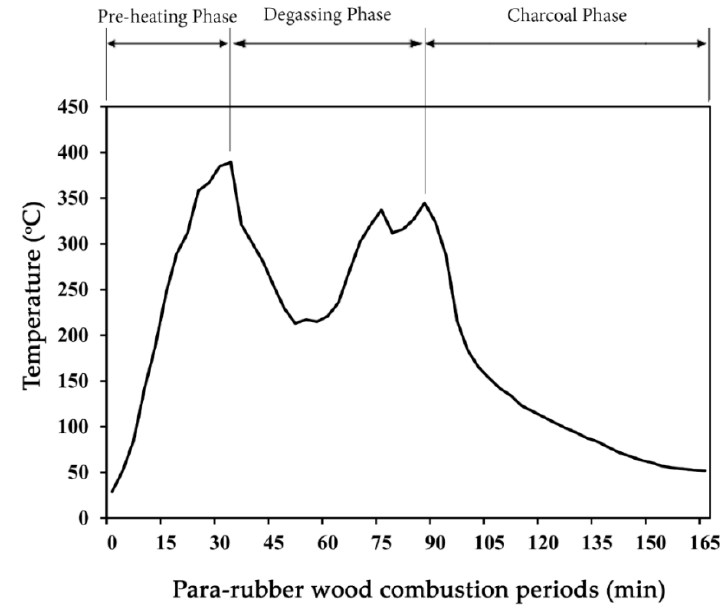
Figure 2. The phase change temperature in para rubber wood combustion.